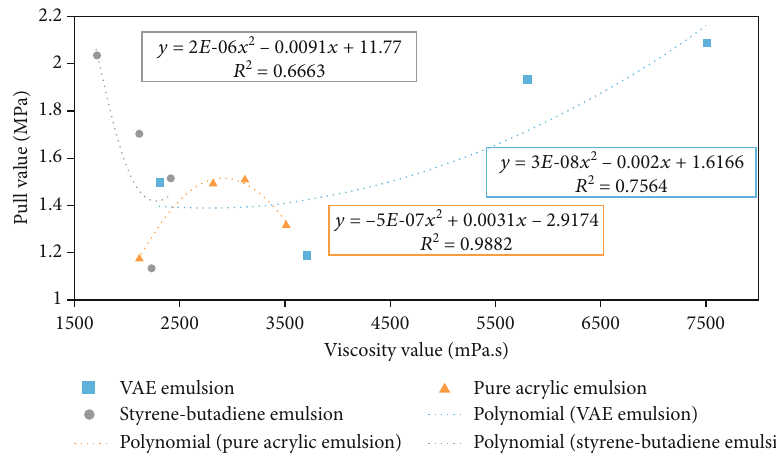
Figure 11: Relationship between the drawing performance and viscosity of three TSL